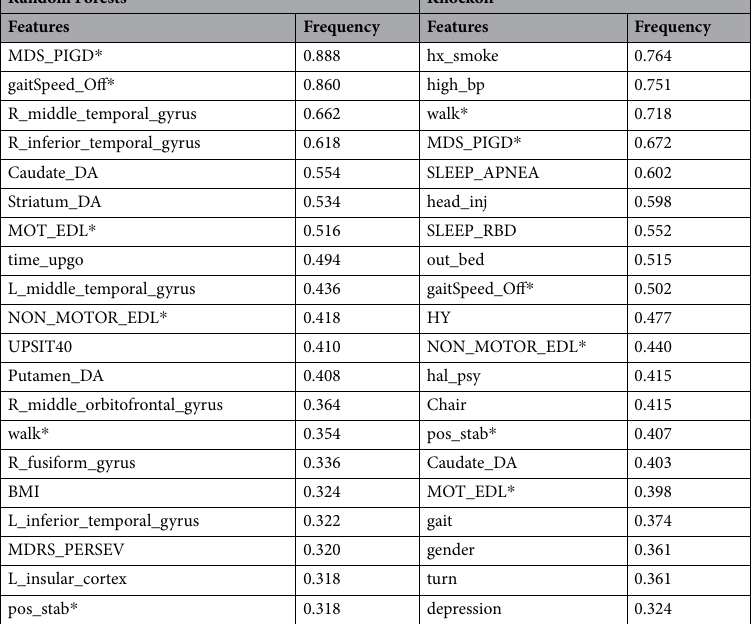
Table 4. Feature selection for the Michigan data using RF (left) and KO (right). Six common features ( * ) are selected by both methods: MDS_PIGD, gaitSpeed_Off, MOT_EDL, NON_MOTOR_EDL, walk, pos_stab.